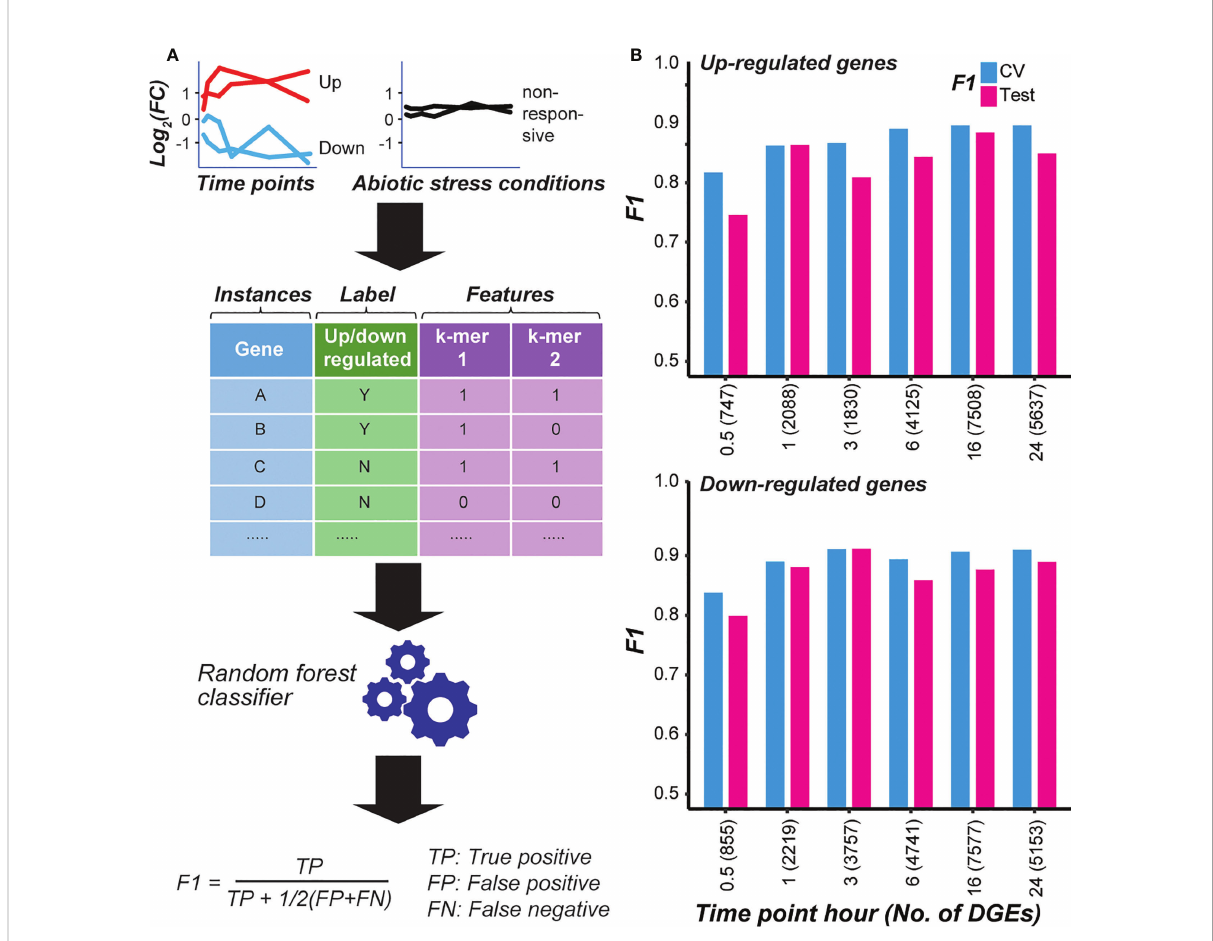
FIGURE 1 Models predicting the cold responsiveness. (A) The overall procedure to model transcriptional response. Genes that are signi fi cantly up- or down-regulated at a cold treatment time point were used as positive examples, while genes not responsive to cold treatment at any time point and to other abiotic stresses (dehydration, salt, and drought) were used as negative examples. k- mers enriched in the gene body and fl anking non-genic regions of the cold-responsive genes were used as predictors (features). RandomForest classi fi er was used to train models, and the model performance was evaluated using the F1 score. (B) Model performances (F1) on the cross-validation (CV) and test sets for each time point model distinguishing genes that were up- (top chart) or down-regulated (bottom chart) after cold treatment for a speci fi c duration from non- responsive genes. The number of positive example genes used in each time-point model is shown in the